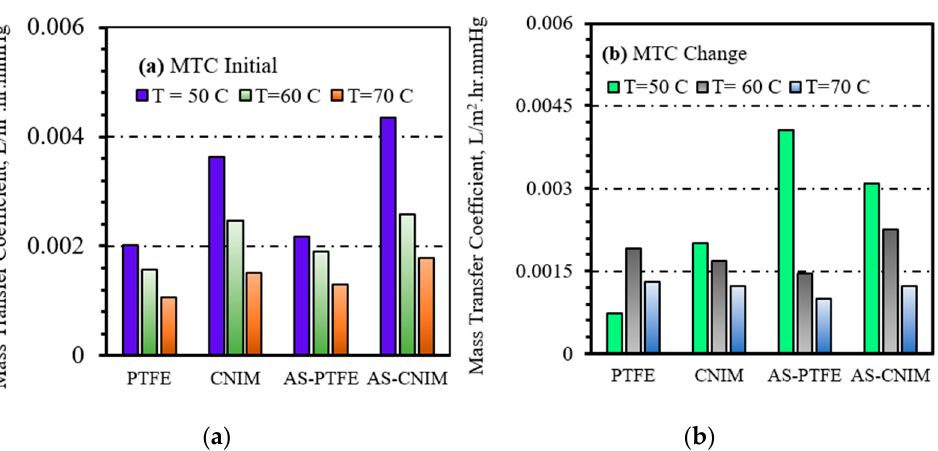
Figure 8. Mass transfer coefficient (MTC) for MD and AS-MD for control PTFE and CNIM membrane. ( a ) MTC initial. ( b ) Change in mass transfer coefficient in membrane -HA system.